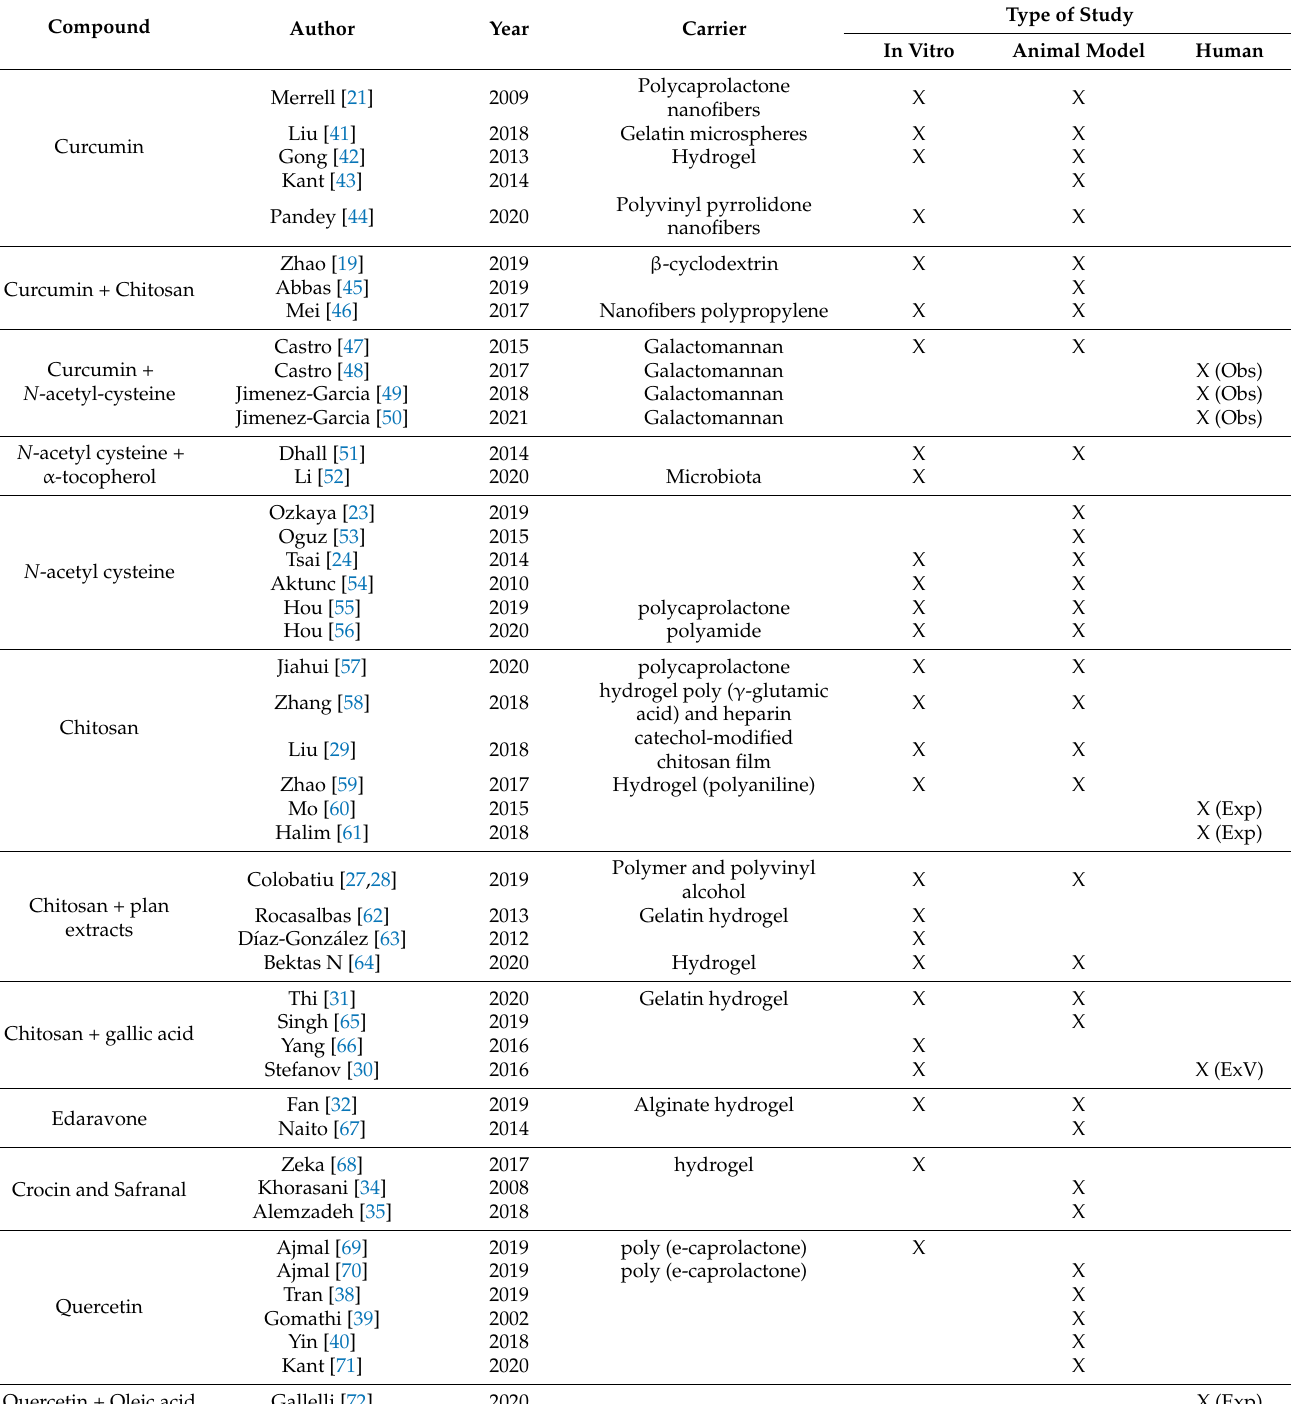
compound are grouped according to the type of research: (1) in vitro or animal models and (2) studies in humans. Table 2. Studies about the effect of the antioxidant compounds on the wound healing process.